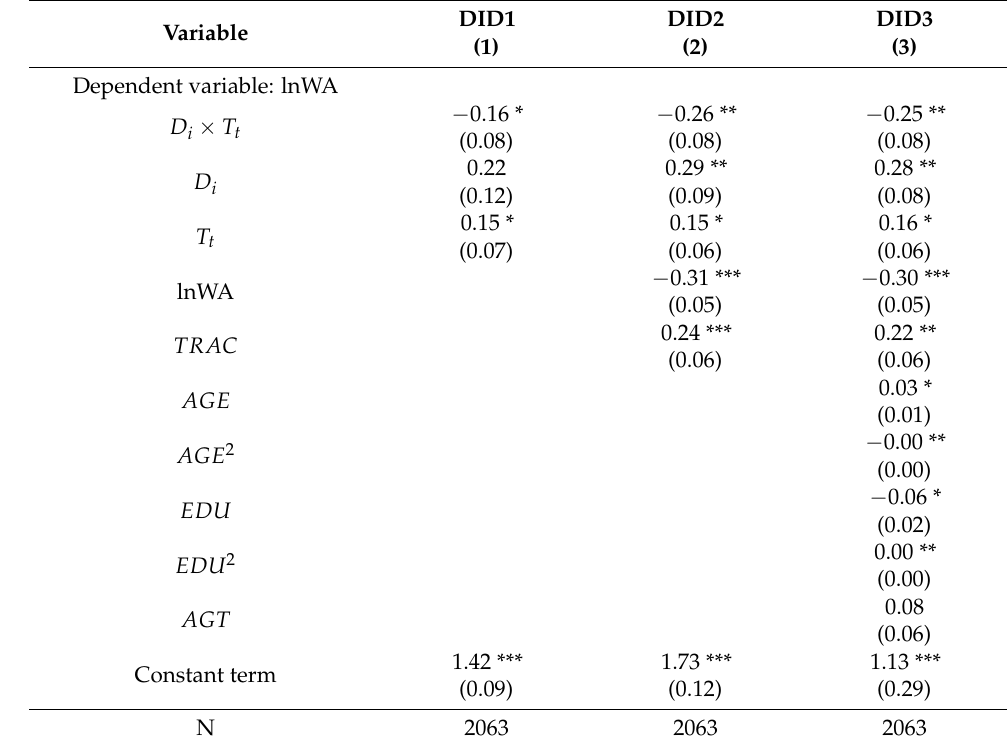
Table 4. Estimation results of the DID